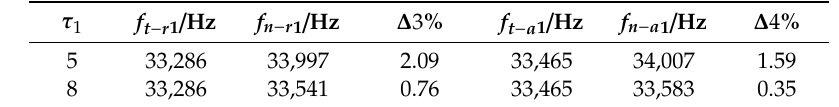
Table 2. Comparisons between the theoretical and simulation results of the No. 1 transducer at τ = 5,8. 1